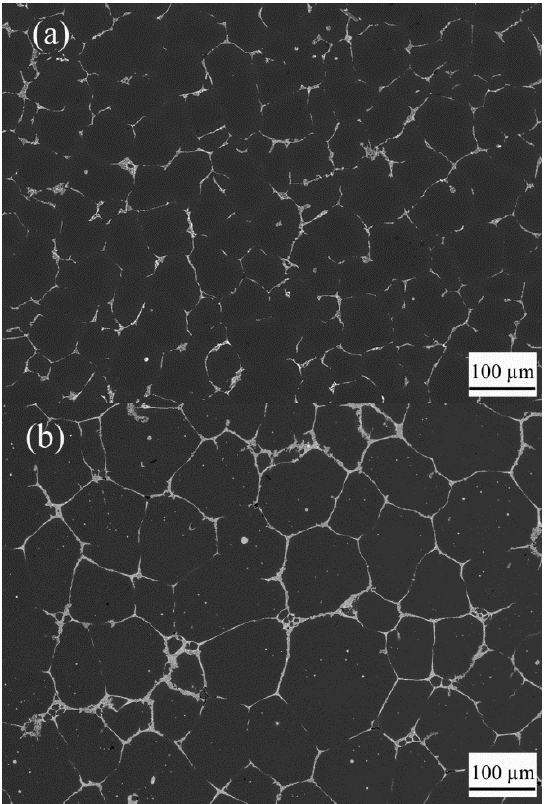
Figure 3. SEM images of the microstructure in Al-4.5 wt.%Cu-2 wt.%TiB 2 alloy under ( a ) as-cast conditions and ( b ) after isothermal coarsening for 1 h (3600 s). The dark globular phase is the aluminum grains. The bright regions surrounding the aluminum grains consist of eutectic phases and TiB 2 particles.